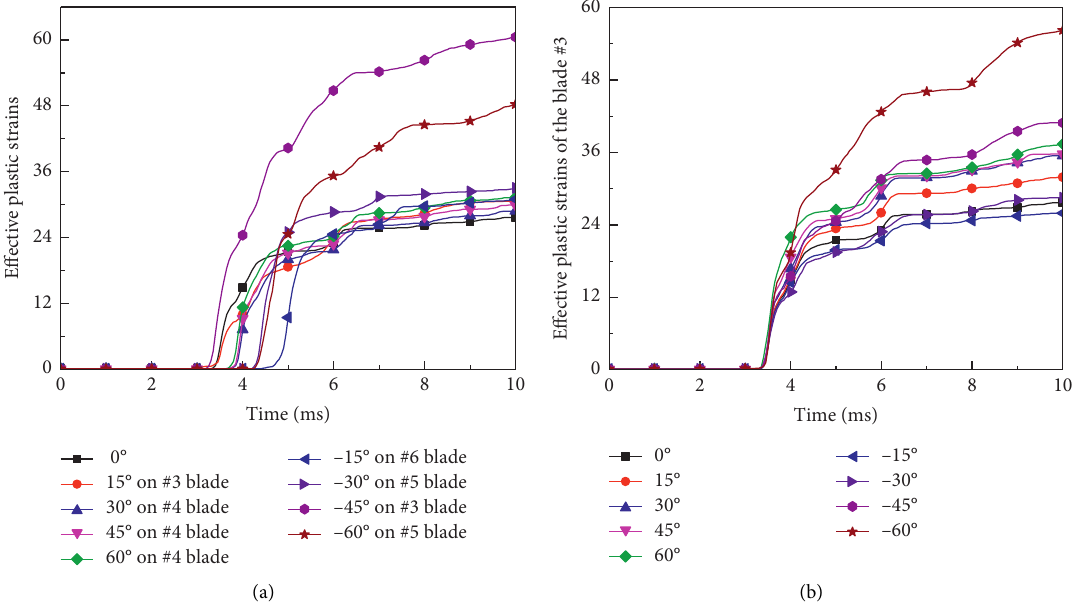
Figure 15: Attitude angle effect on blade damage. (a) Yaw angle α . (b) Pitch angle β